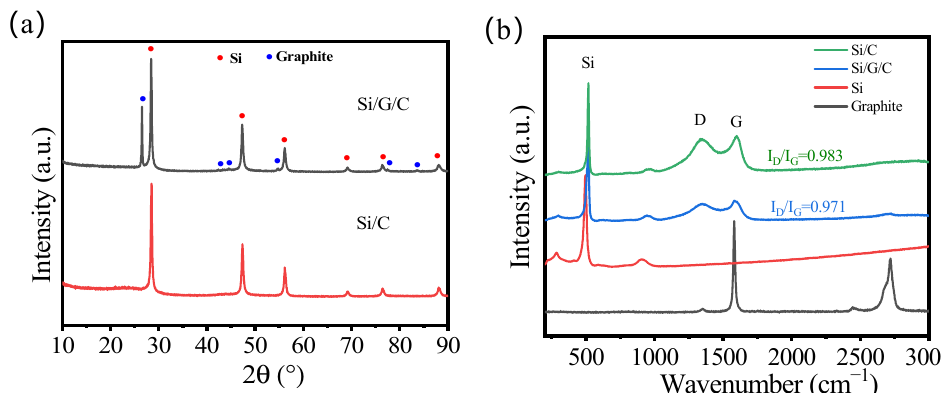
Figure 1. ( a ) XRD patterns; ( b ) Raman spectra of various samples.